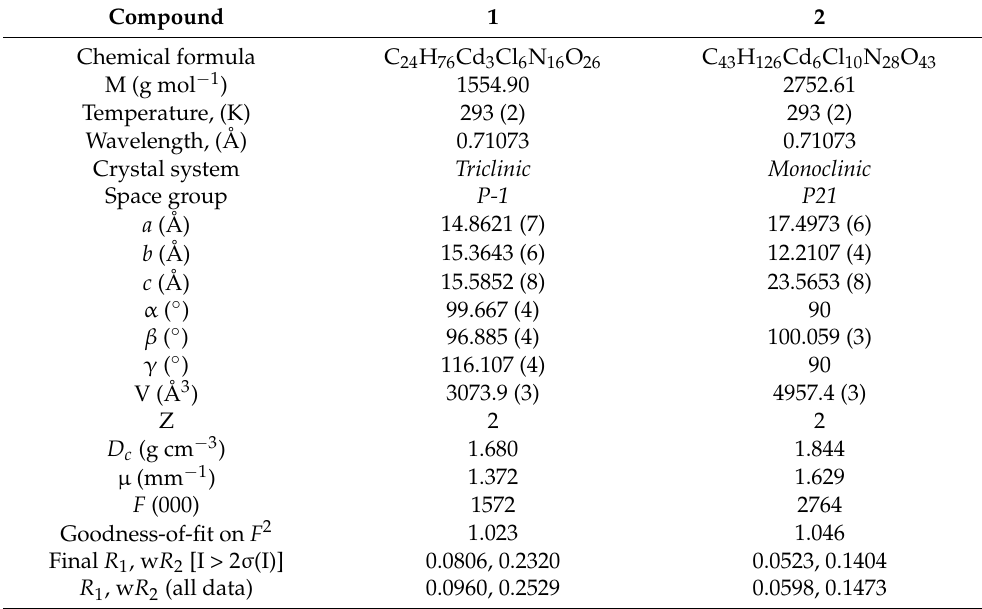
Table 1. Crystallographic data, details of data collection and structure refinement parameters for compounds 1 and 2 .